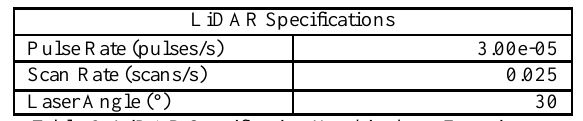
Table 2: LiDAR Specification Used in these Experiments